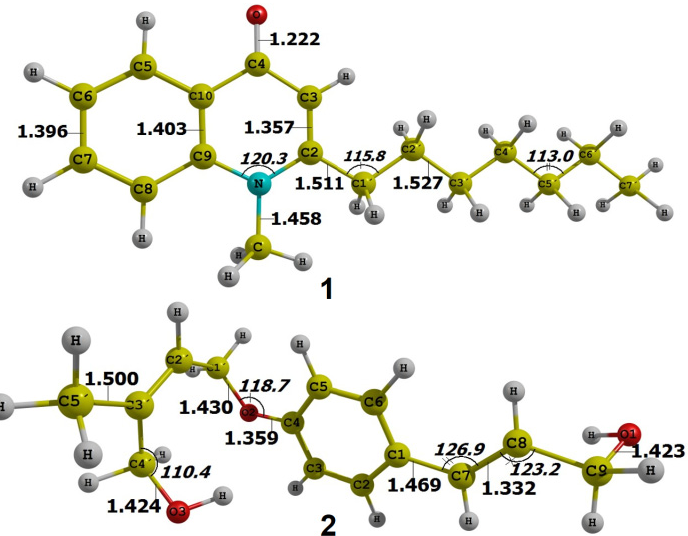
Figure 5. Optimized structures of the isolated compounds 1 and 2 calculated by DFT using basis M052X/6-311++G(d,p).